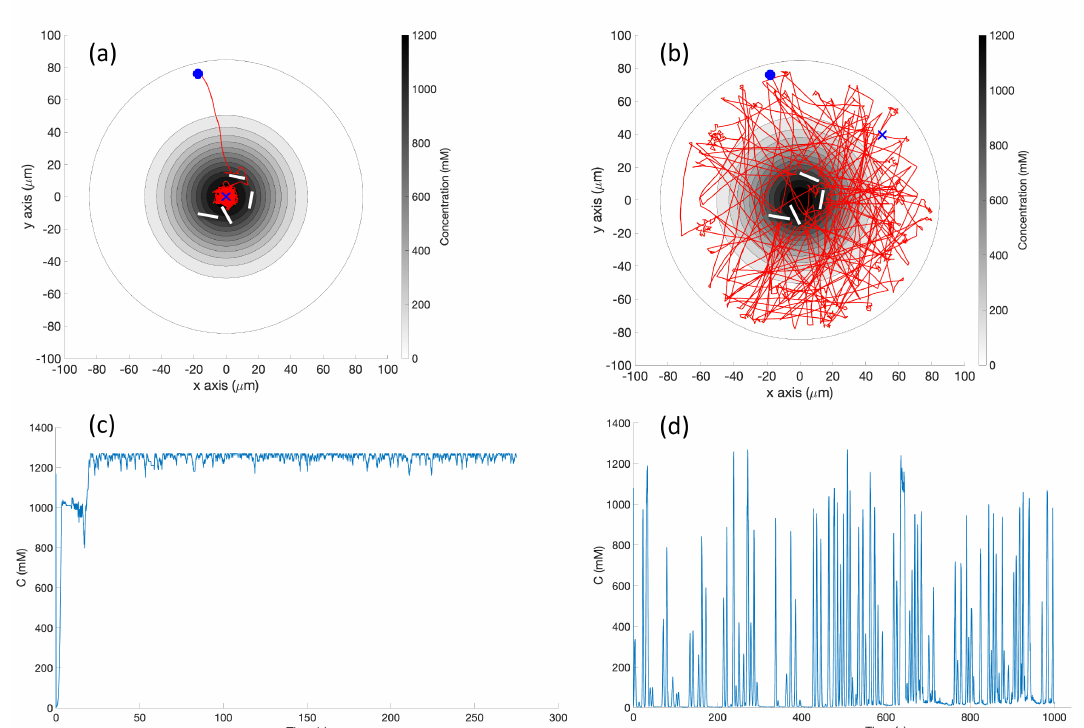
Figure 17. Case 8: With obstacles, in the single-effluent environment, typical trajectories of the simulated robot running ( a ) the basic chemotaxis controller, and ( b ) the RapidCell chemotaxis controller. The contour plot represents the concentration distribution shown in Figure 5 (left) where the outmost level curve represents the concentration at 1m M . In each trajectory, the initial position is shown as a blue circle and the terminal position is shown as a blue “X”. Positions corresponding to concentrations less than 1m M are shown in dashed green, otherwise shown in red. The recorded concentrations associated with each scheme are shown in ( c , d )